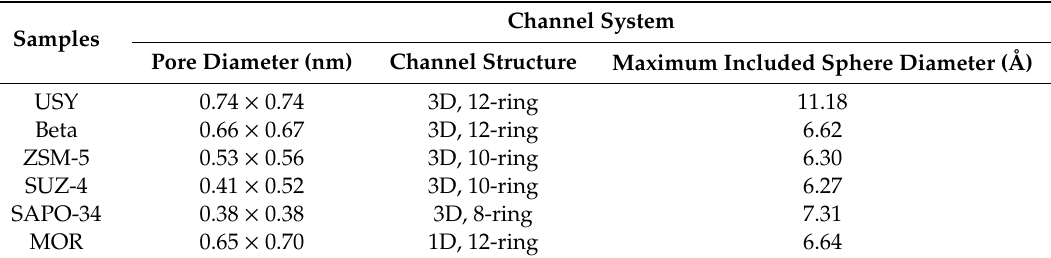
Table 2. Structural properties of different zeolite framework types.